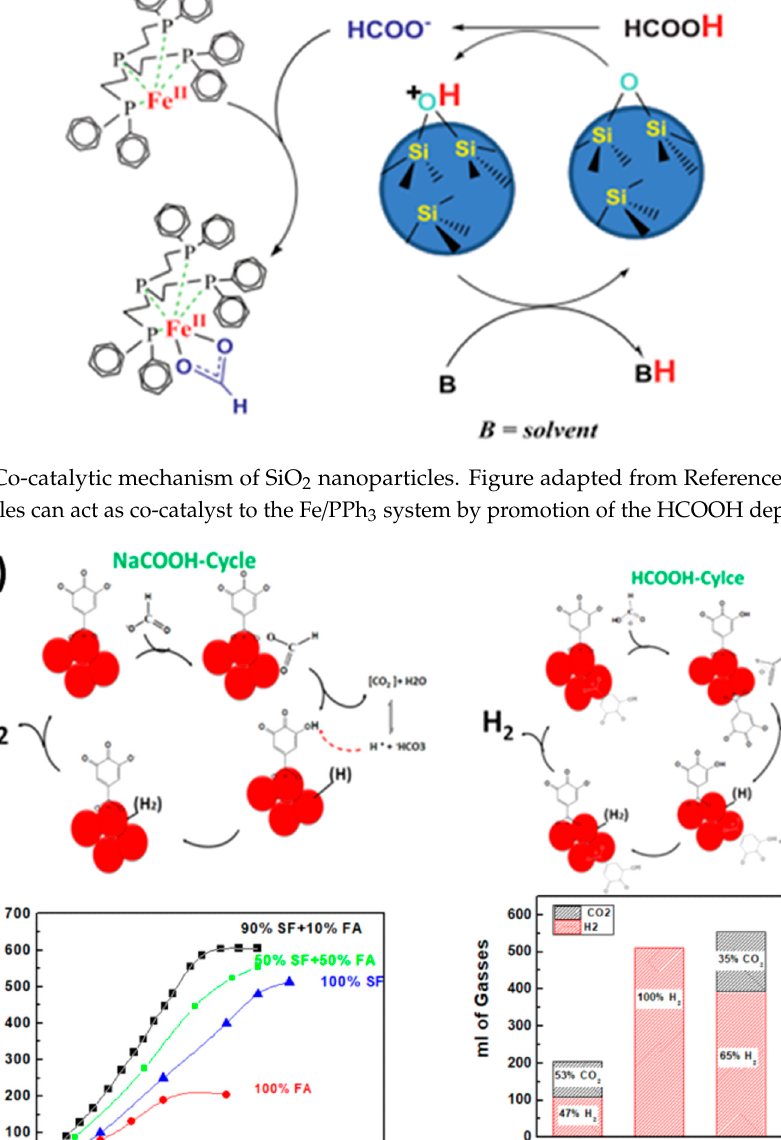
Figure 7. ( A ) Proposed catalytic cycles for Pd@SiO 2 -GA nanoparticles (NPs); ( B ) catalytic results obtained from Pd@SiO 2 -GA system. Figure adapted from Reference [55].